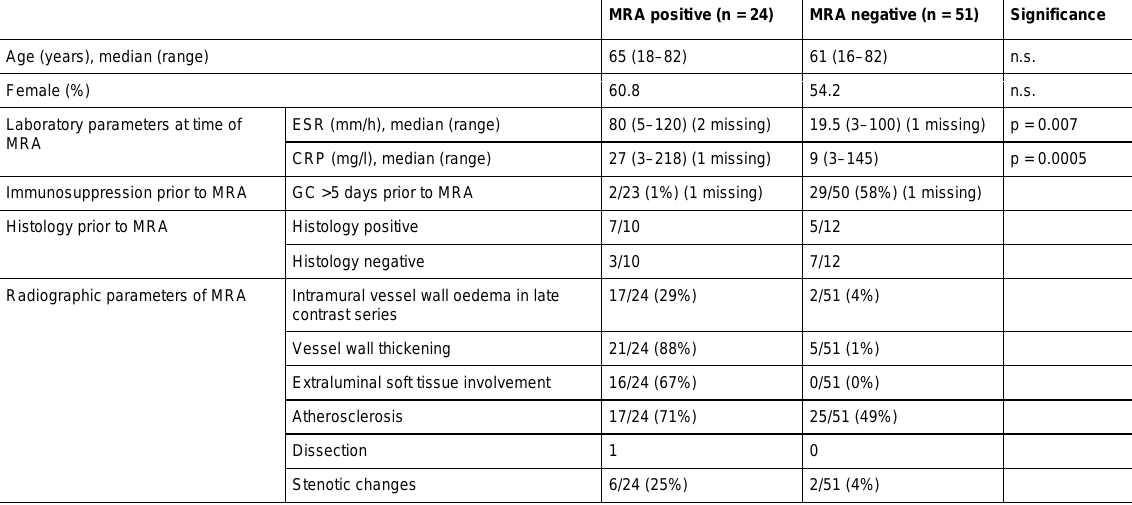
Table 1: Overview of patient characteristics: laboratory, histological and radiographic parameters. Total n = 75. CRP = C-reactive protein; ESR = erythrocyte sedimentation rate; GC = Glucocorticoids; MRA = magnetic resonance angiography; n.s. = not significant.